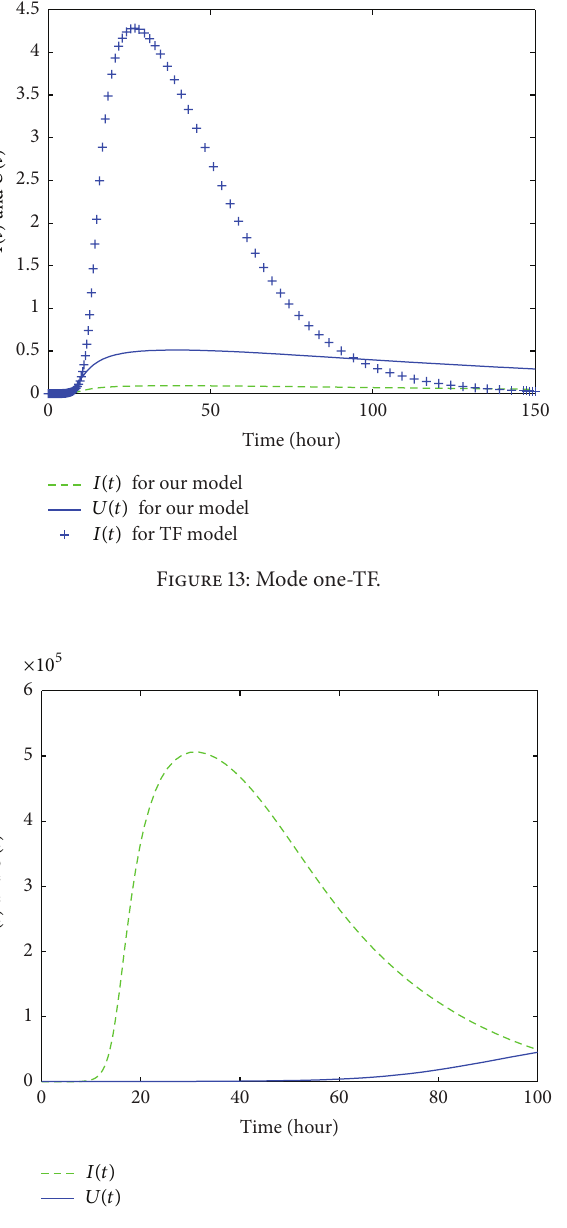
Figure 14: Mode two.